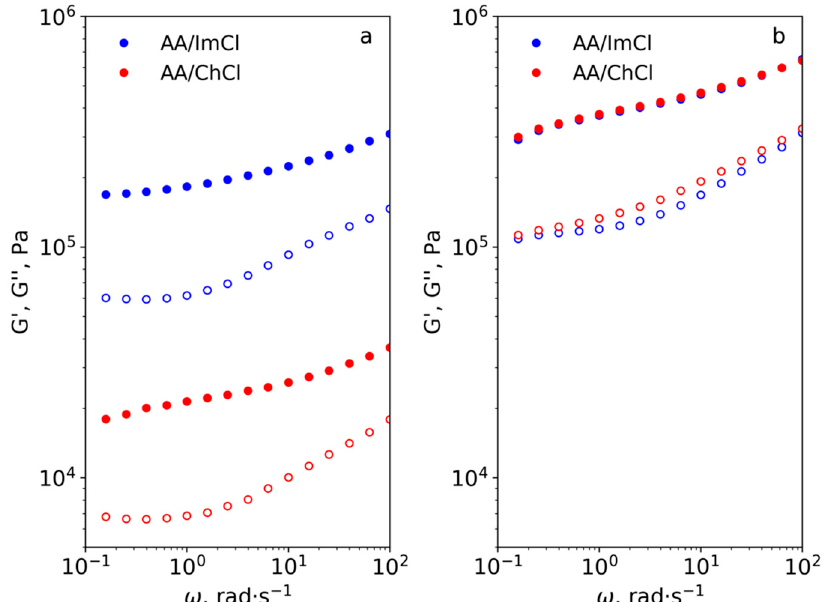
Figure 9. Storage (G’, filled symbols) and loss (G ′′ , hollow symbols) moduli as a function of angular frequency ( ω ) for dispersions containing 0.5 wt% ( a ) and 1 wt% ( b ) of CNF at 20 °C.